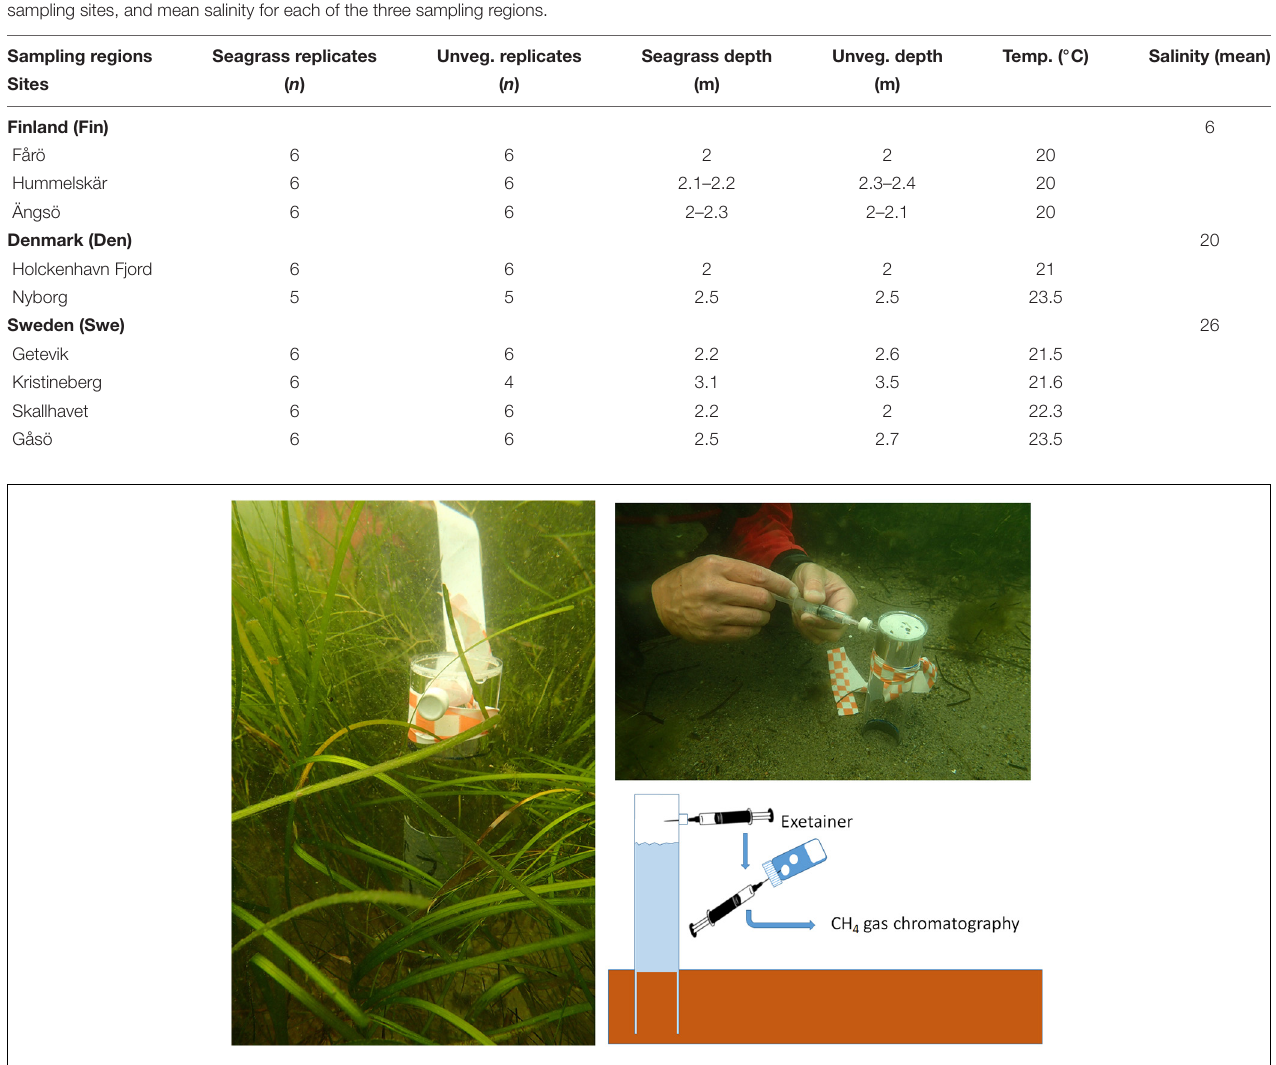
FIGURE 2 | Deployed incubation chamber in a seagrass meadow (left) and collection of a gas sample (top right). Illustration (bottom right) of the sampling methodology using an incubation chamber inserted 15 cm into sediment with a 20 cm water column above the sediment. On the top, a 5 cm air-pocket